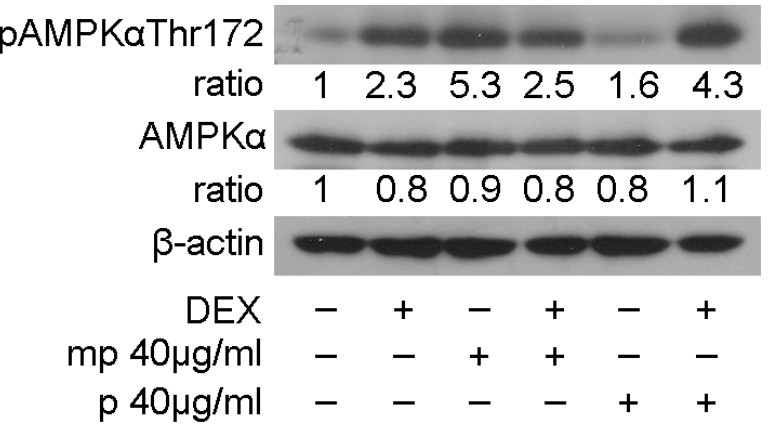
Figure 5. Chios Mastiha fractions cause phosphorylation of AMPK α protein levels. Western blot analysis of β -actin, AMPK α , and phosphorylated AMPK α protein levels in HEK293 cell extracts precultured in hormone-free medium for 48 h and subsequently treated with 40 µ g/mL Mastiha fractions for 45 min. Ratios result from normalization of pAMPK α Thr172 and AMPK α bands intensity to the respective β -actin ones. Relative protein levels in control cells were set as 1.